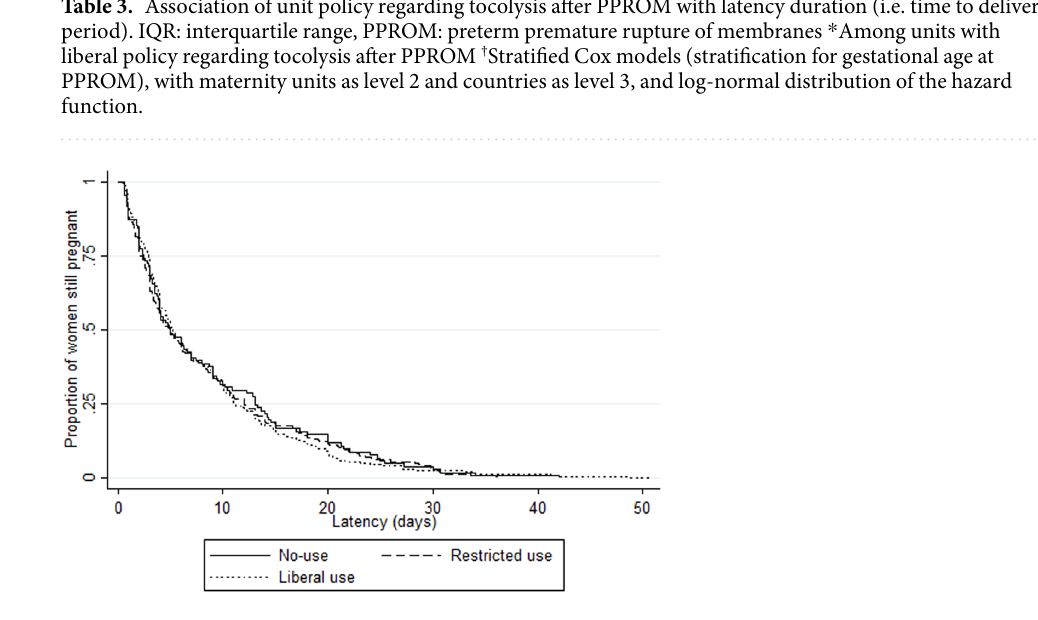
Figure 2. Kaplan Meier survival curves of latency duration by unit policy regarding tocolysis after PPROM. There was no difference in Kaplan-Meier curves of latency duration by unit policy regarding tocolysis after PPROM (logrank test p = 0.88).